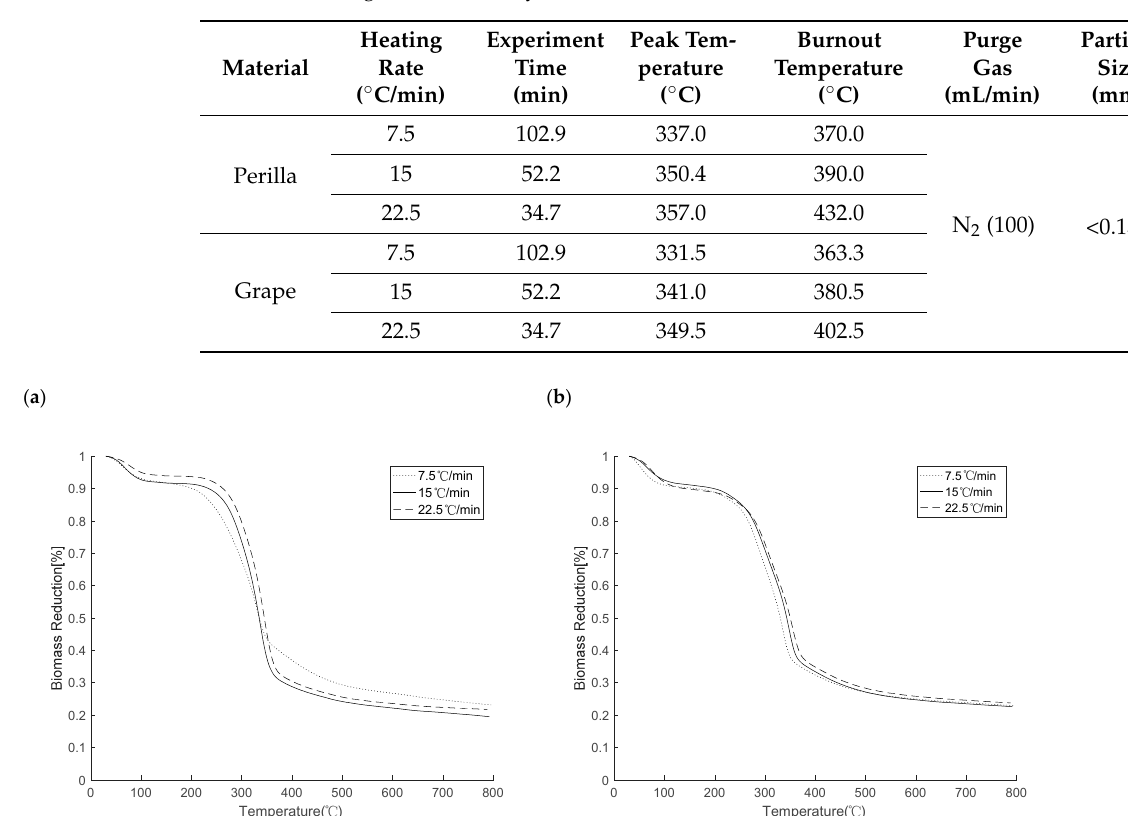
Figure 9. Arrhenius plot of TGA data measured at different heating rates of grape branch ( a ) and perilla ( b ).